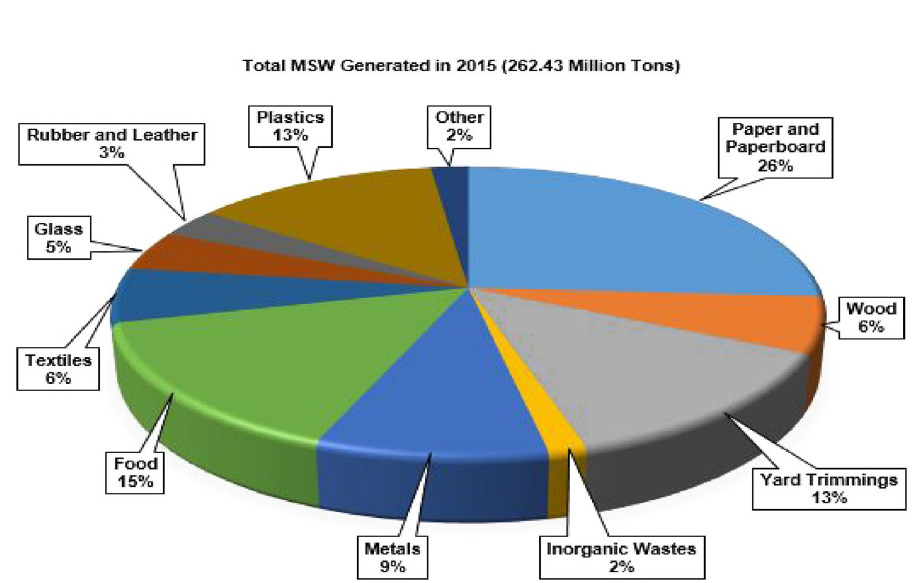
Fig. 6 Composition of waste materials in a good amount of countries (Recreated After Pappu et al. 2007; EPA 2015; Mian et al. 2016; Alfaia and Campos 2017; Rodriguez et al. 2015; Nelles et al. 2016; Amemiya 2018; Government Statistical Service 2019; UN Environment Programme 2016; Miandad et al. 2016)